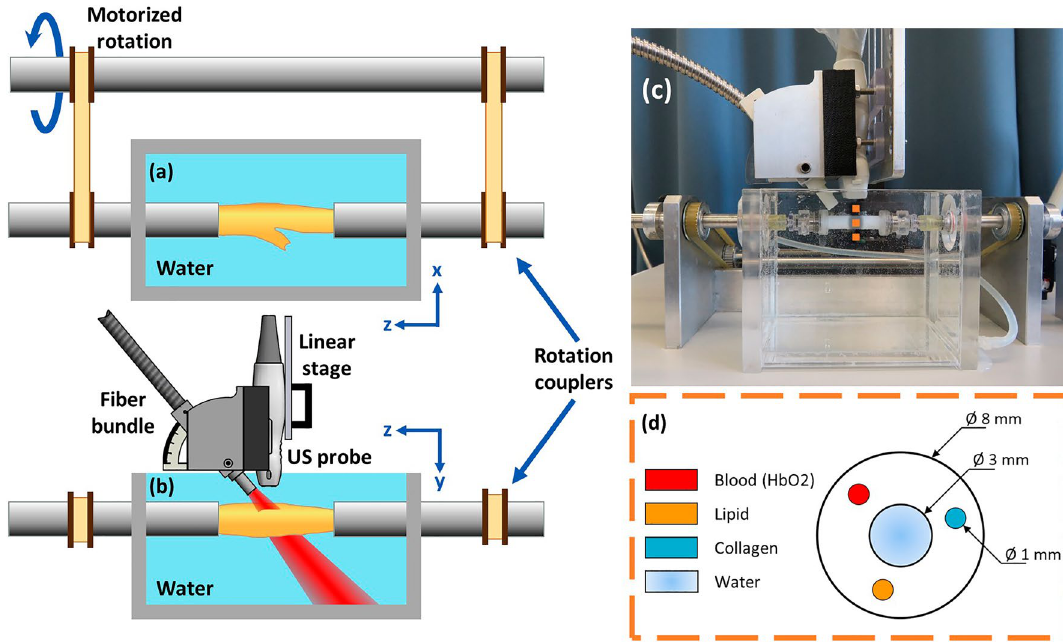
Figure 1. Imaging setup. ( a ) Schematic of the imaging setup top view and ( b ) side view. The fiber bundle and probe are attached to a linear movement stage for positioning, and the sample can be rotated for multiple perspective acquisition. ( c ) Photograph of the photoacoustic setup side view with a PVA vessel phantom. ( d ) Schematic of the three-channel phantom used for the method